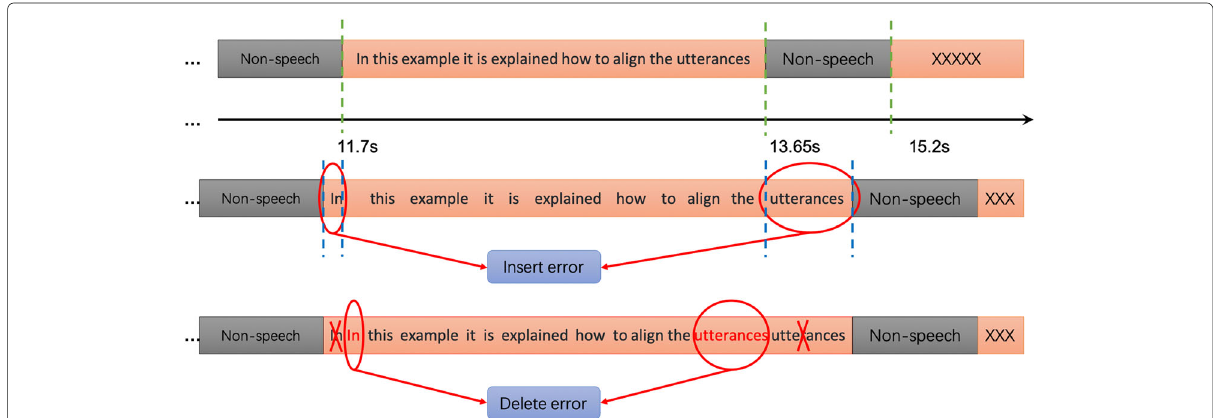
Fig. 5 An example how alignment affects segmentation-aware WER. Orange blocks represent handcrafted speech segments (above) or SAD-classfied speech segments (middle and